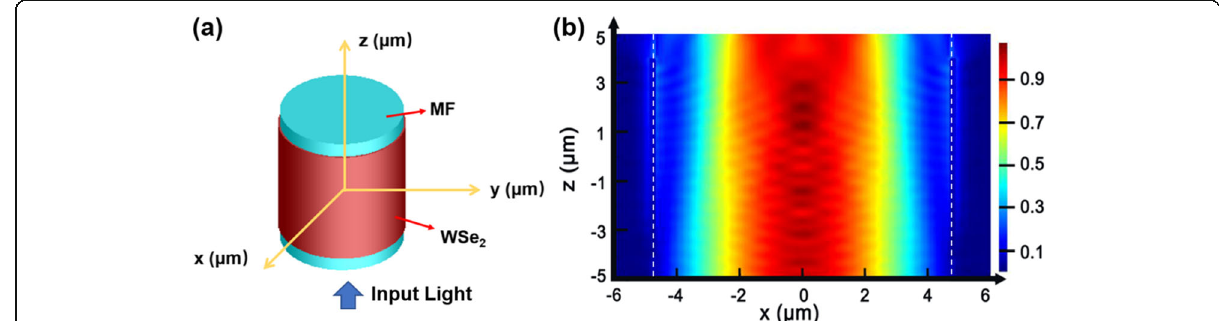
Fig. 16 a The schematic of the device configuration for calculation with 3D FDTD. b The electric field distribution in the x - z plane cross